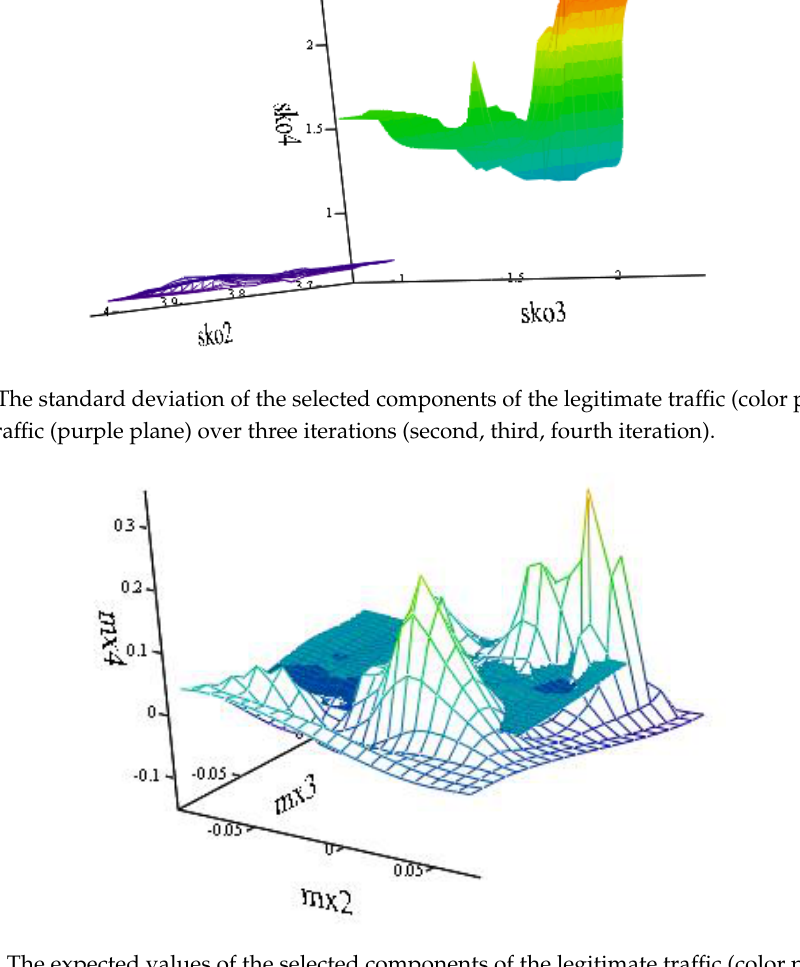
Figure 10. The expected values of the selected components of the legitimate traffic (color plane) and